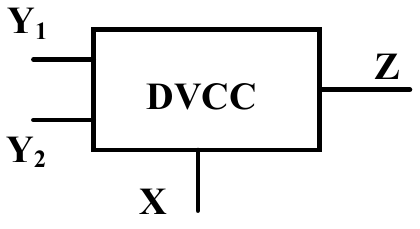
Figure 1. DVCC block diagram.